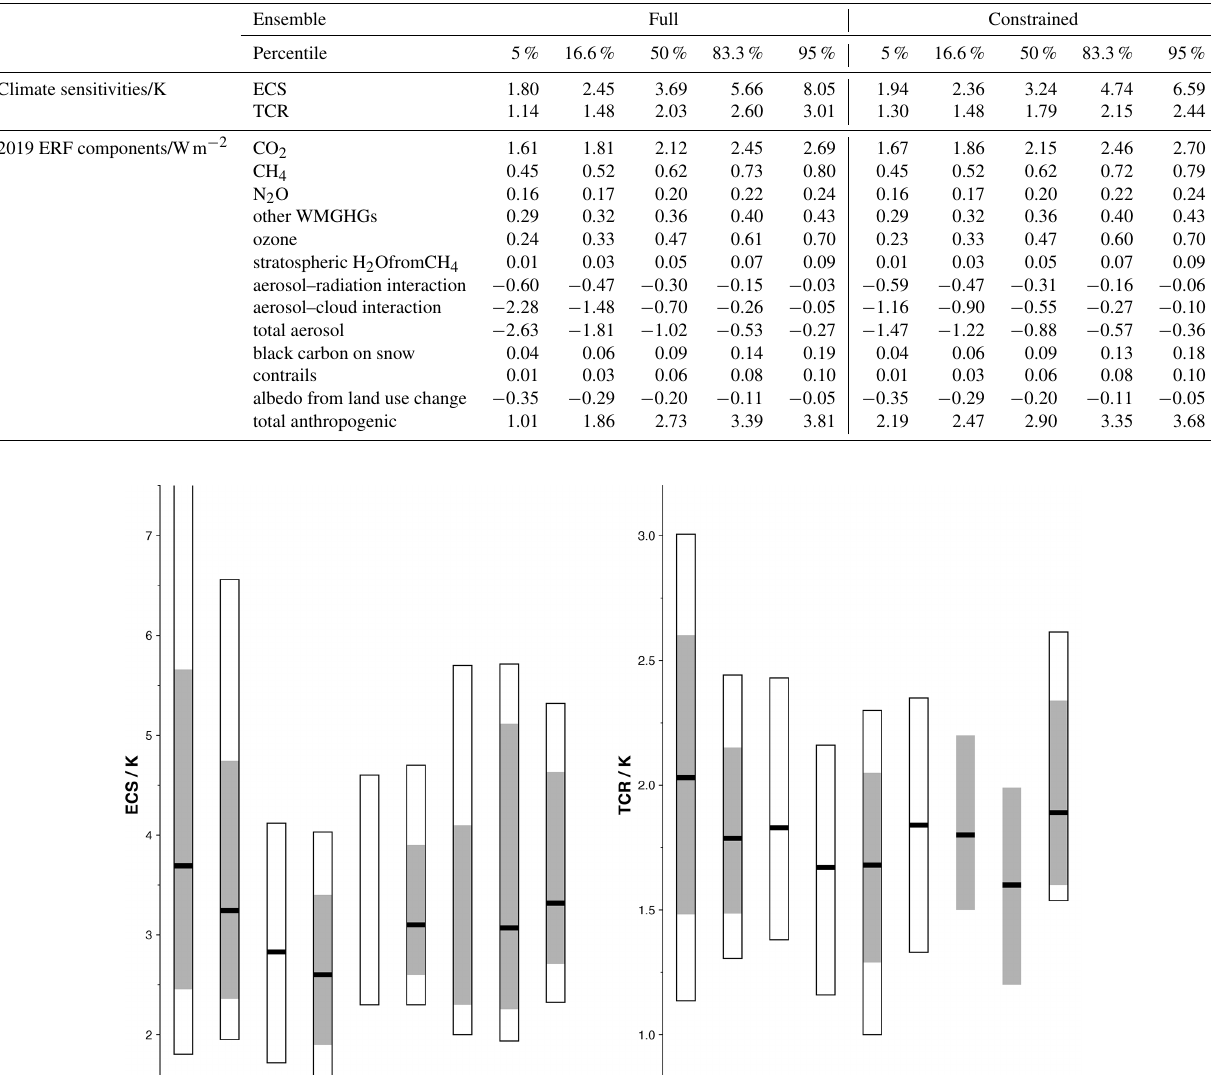
Table 7. Constrained ensemble results for climate sensitivities and current ERF. ERF in 2019 is based on following an SSP2-4.5 pathway from 2014 onwards.